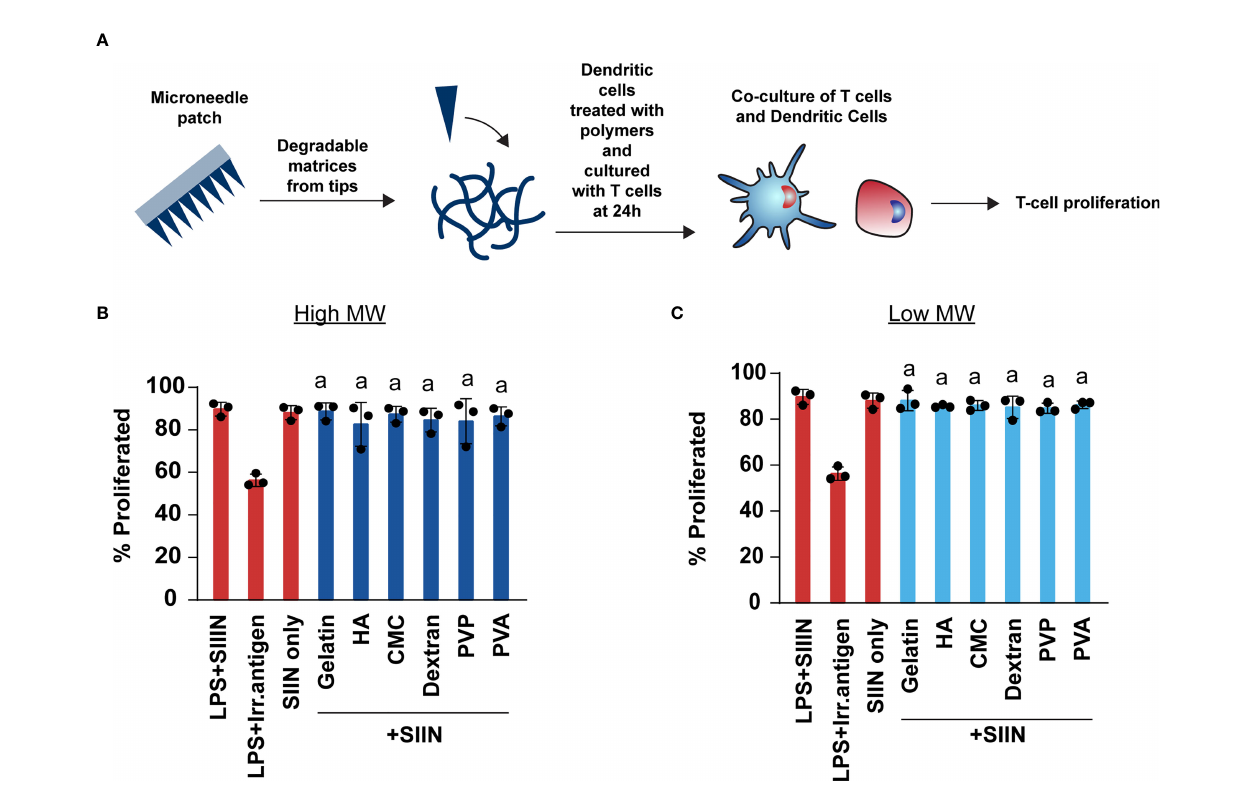
FIGURE 7 | Polymer MNs do not limit the ability of T cells to engage with their antigen or proliferate. (A) Schematic showing experimental set-up for T cell co-culture experiments. (B, C) Proliferation of T cells when treated with high and low MW polymer MNs, respectively. “ a ” represents signi fi cant statistical differences (p < 0.05) when compared with LPS+ irrelevant antigen (irr. antigen). The comparison between LPS+SIIN and SIIN with the polymer MNs was not signi fi